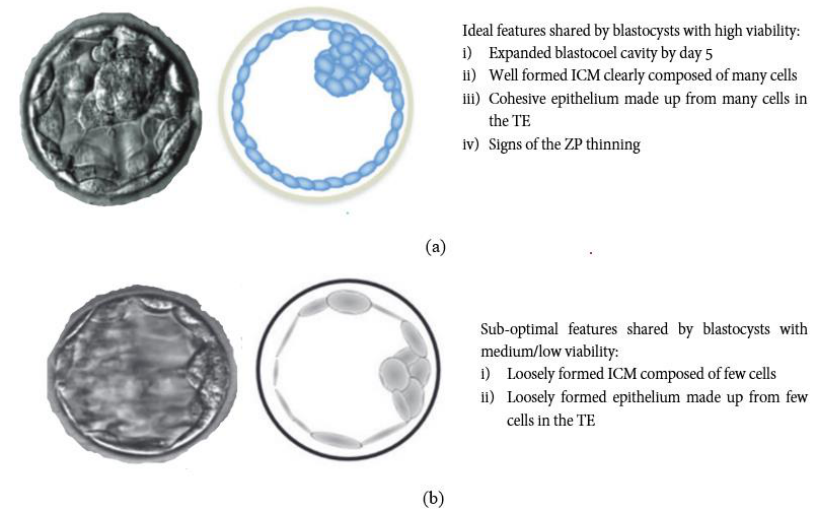
Figure 4. Key morphological features of human blastocyst with ( a ) high viability and ( b ) medium/low viability (according to ICM and TE features) based on the Gardner scoring system [38,41].